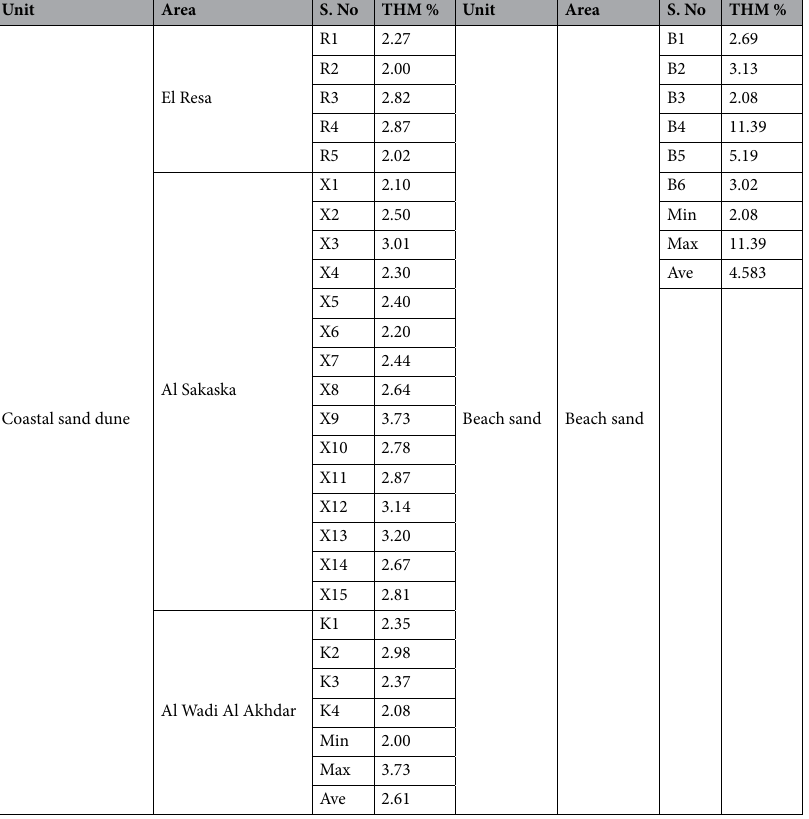
Table 1. Percentages of total heavy minerals (THM) separated by bromoform solution for the studied